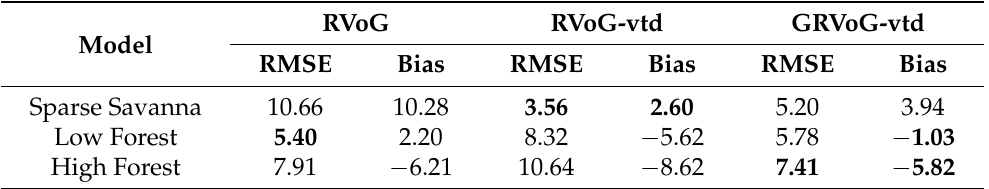
Table 2. Hight estimation error comparisons of three models for different vegetation types. The bold numbers mean the least RMSE and least bias in each